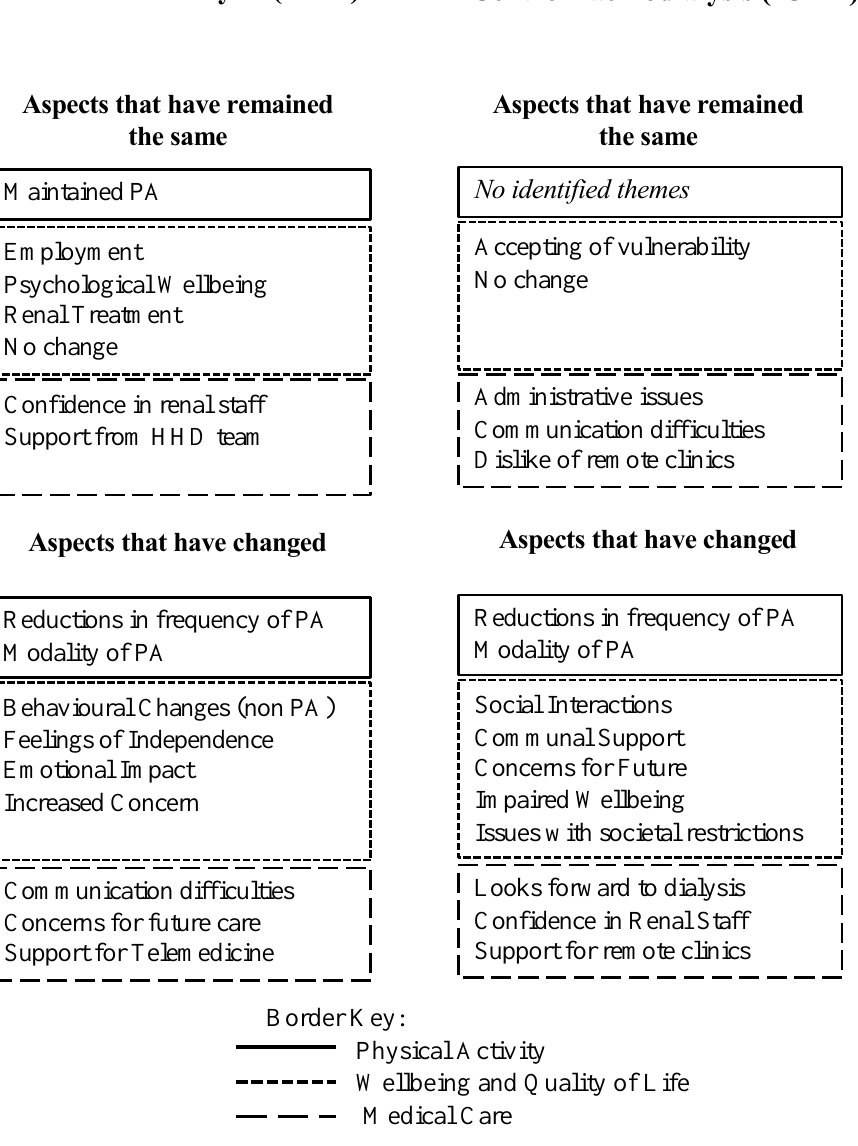
Figure 1. Summary of the themes identified during thematic analysis. These denote the key thematic areas discussed as having been changed or not changed as a result of the COVID-19 re- strictions. N.B. PA, physical activity.